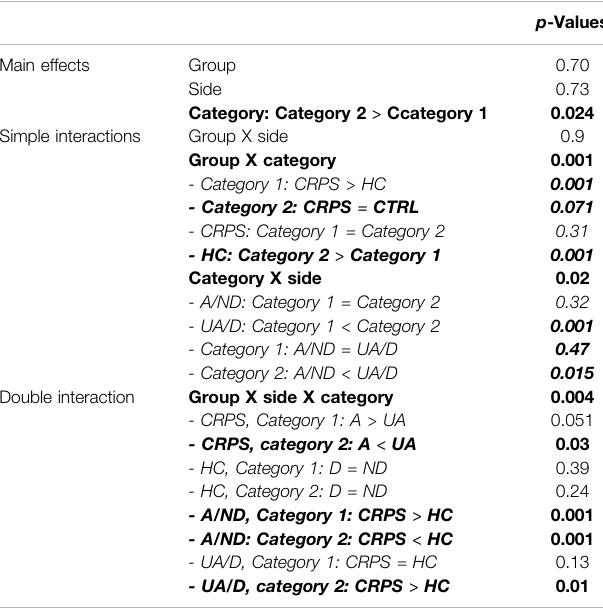
TABLE 3 | p -values of the nparLD analysis for Con fl ict sensitivity. Bold indicates signi fi cant effects. Italic indicates p -values for post-hoc